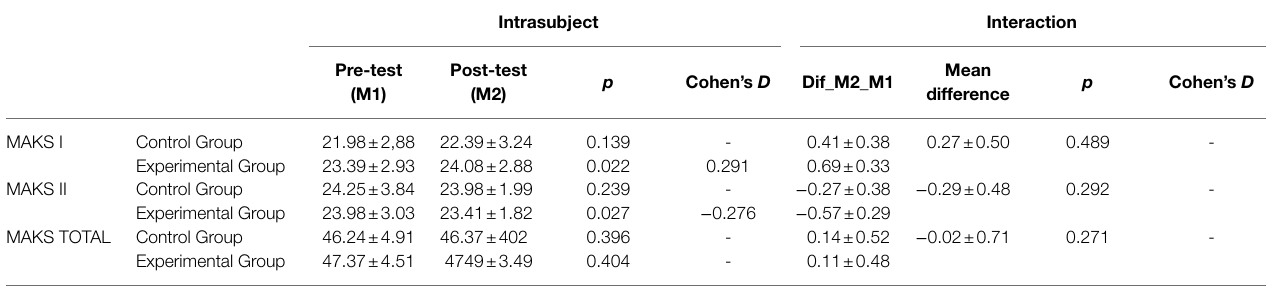
TABLE 3 | Comparative analysis of the means for the pre- and post-test Mental Health Knowledge Schedule (MAKS) in the control and experimental groups.